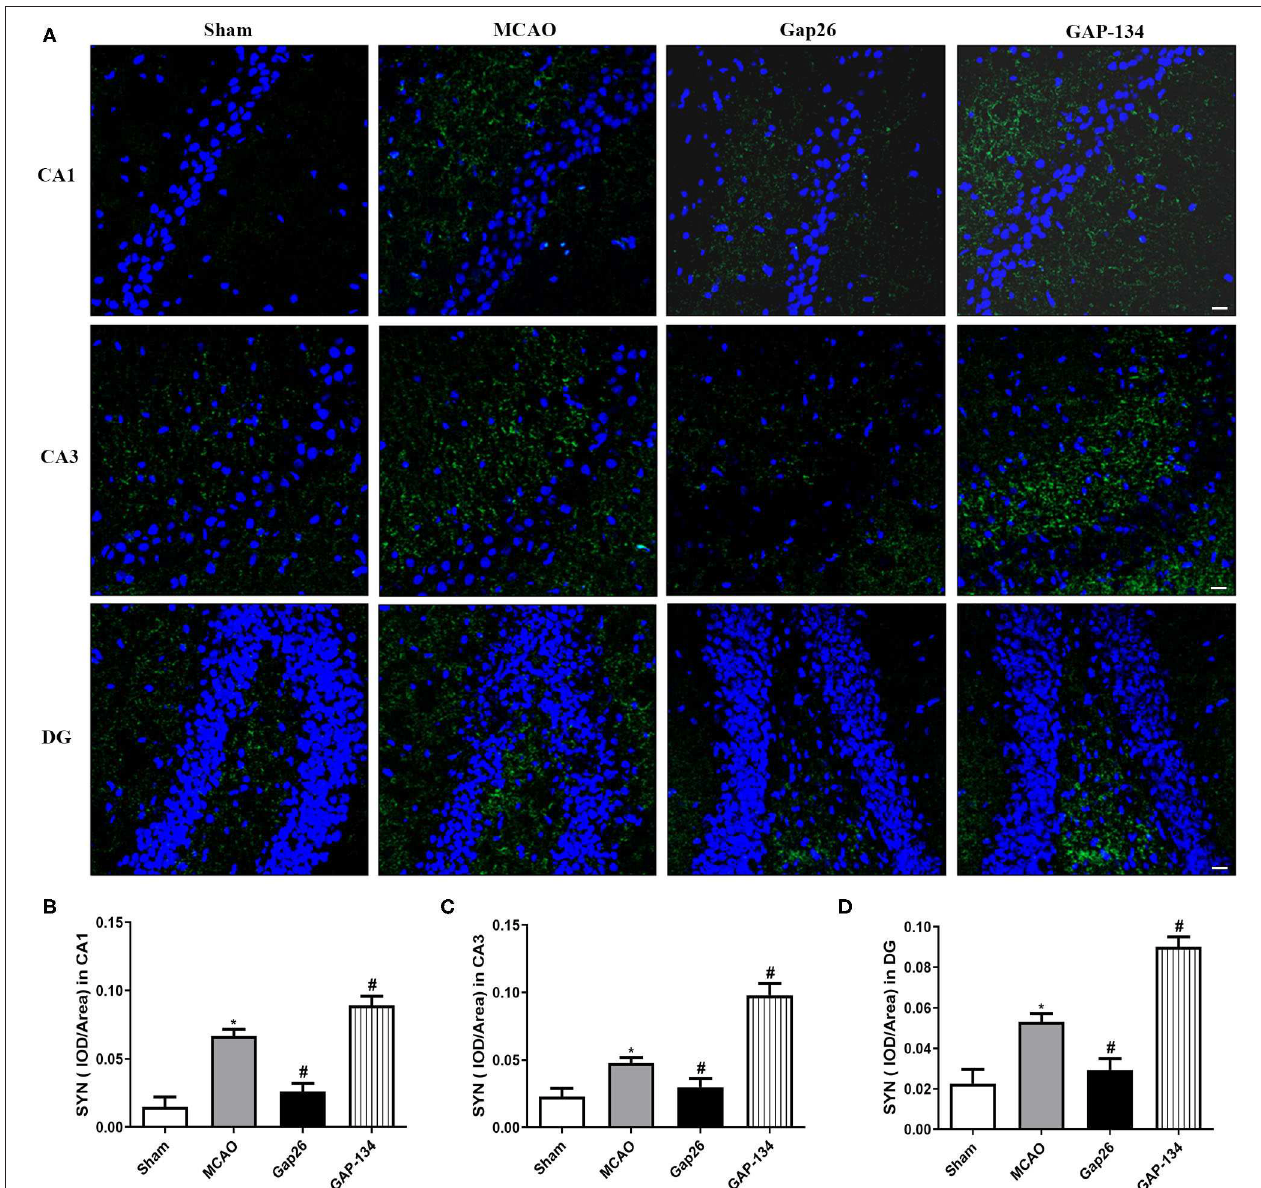
FIGURE 5 | Effects of Gap26 and GAP-134 on the expression of SYN at 7 d after MCAO. Data were shown as mean ± SEM, n = 6. (A) Representative pictures of SYN in hippocampal CA1, CA3, and DG. Blue depicts staining of DAPI (cell nuclei), and green depicts staining of SYN. Scale bar = 20 µ m. (B–D) Quantitative analysis showed that expression of SYN was decreased by Gap26 but increased by GAP-134 in hippocampal CA1, CA3, and DG (* P < 0.05 vs. sham, # P < 0.05 vs.